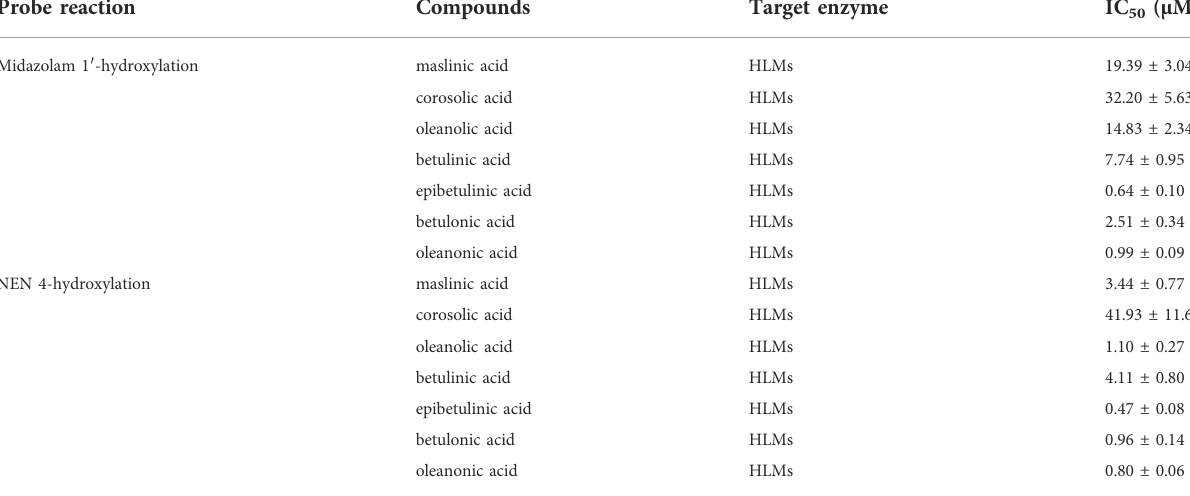
TABLE 3 Inhibitory effects of pentacyclic triterpenoid acids on CYP3A in HLMs. Data are the mean ± SD. Probe